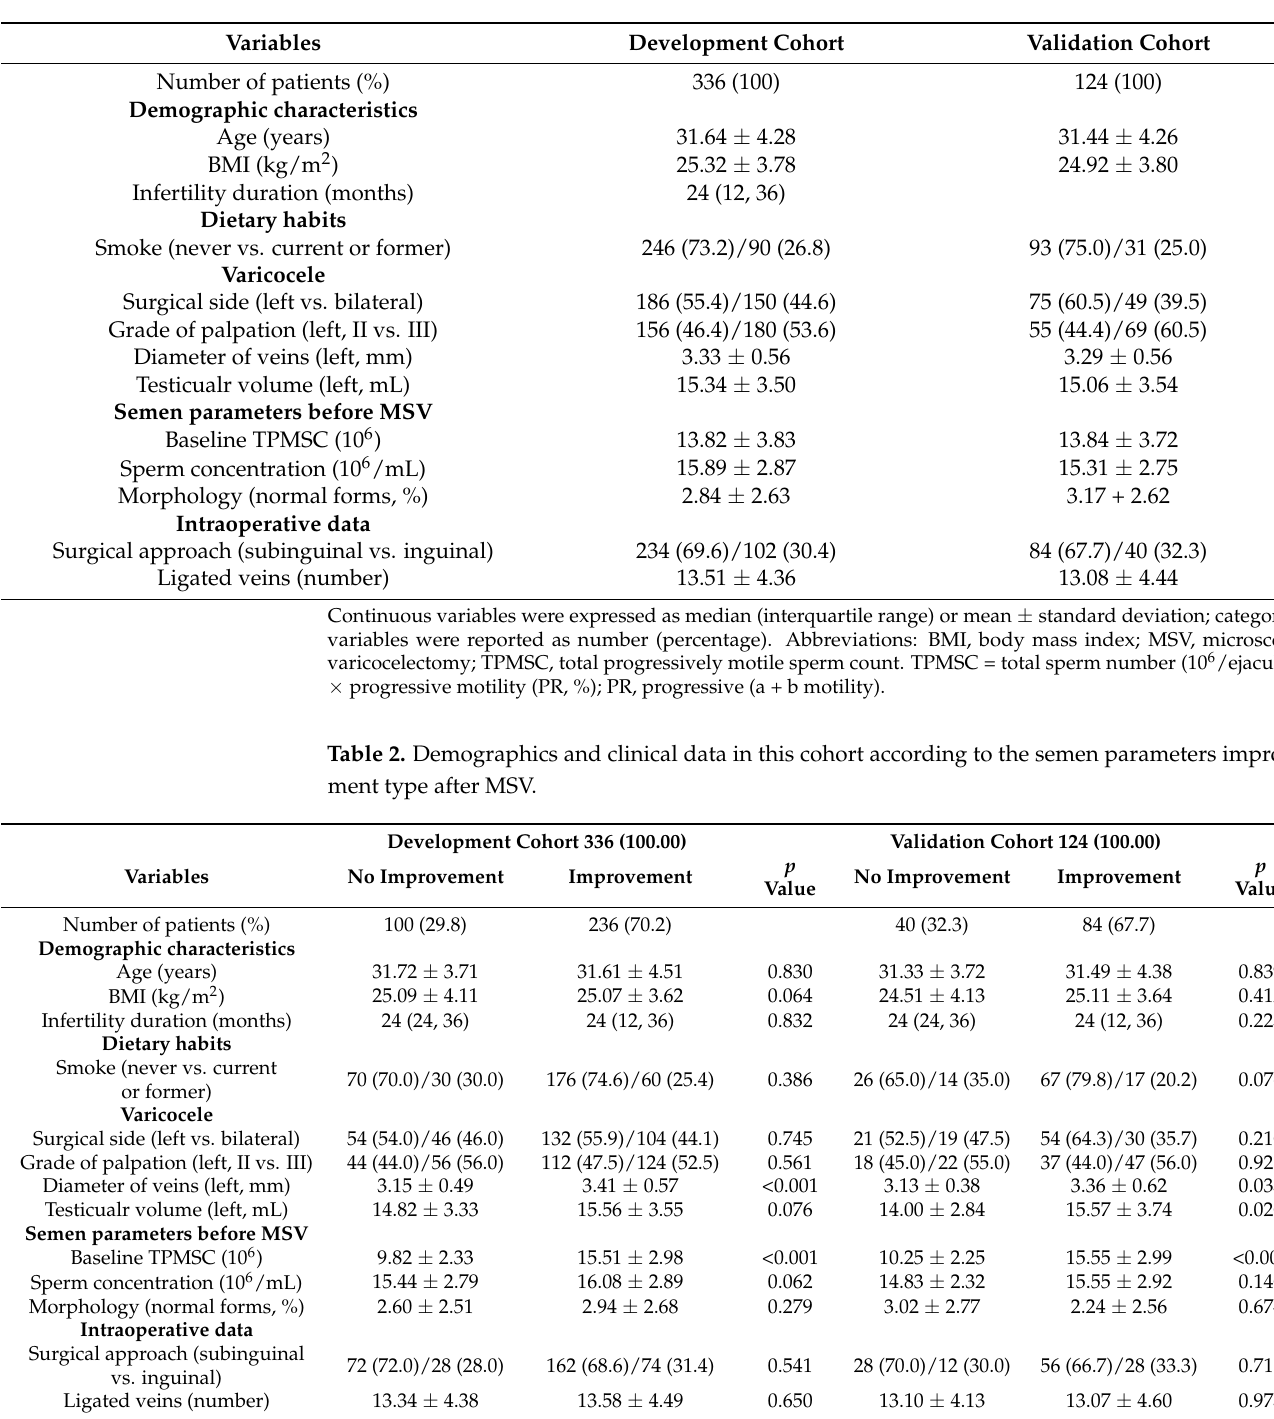
Table 1. Demographics and clinical data in this cohort according to the development cohort and validation cohort.